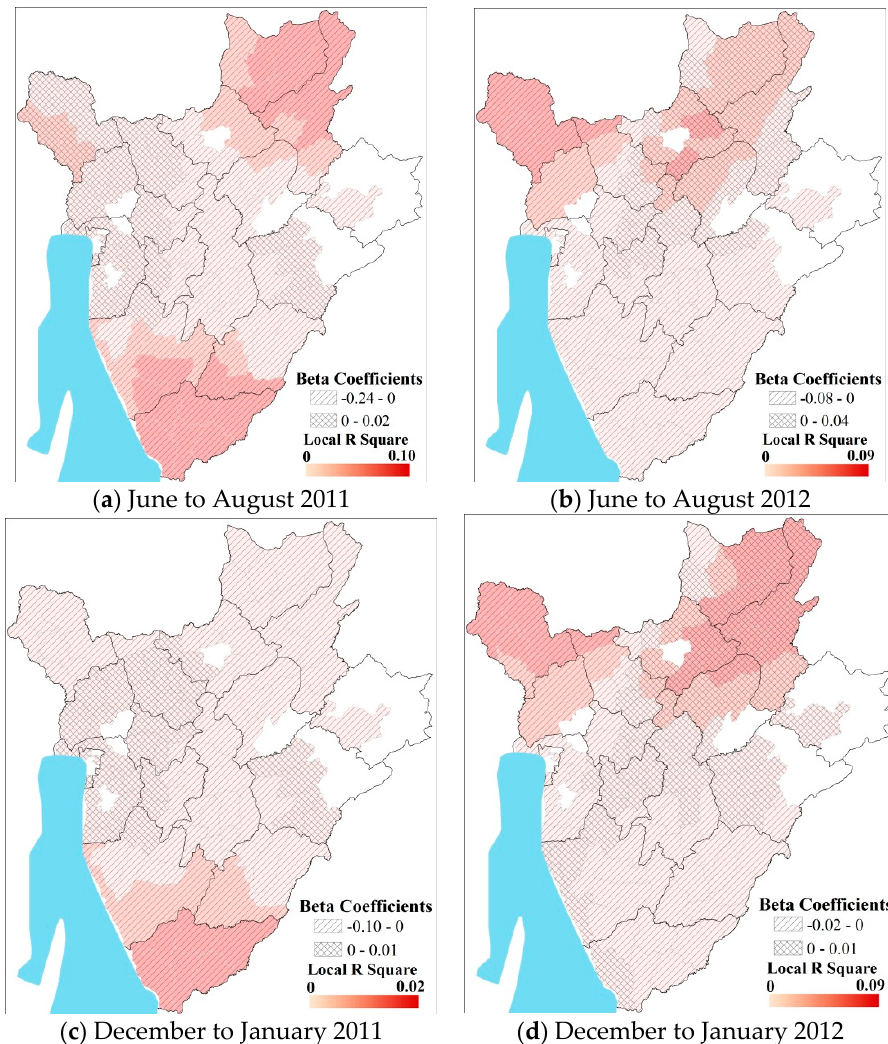
Figure 3. Results of GWR analysis during the dry seasons ( a ) June to August 2011; ( b ) June to August 2012; ( c ) December to January 2011; ( d ) December to January 2012.